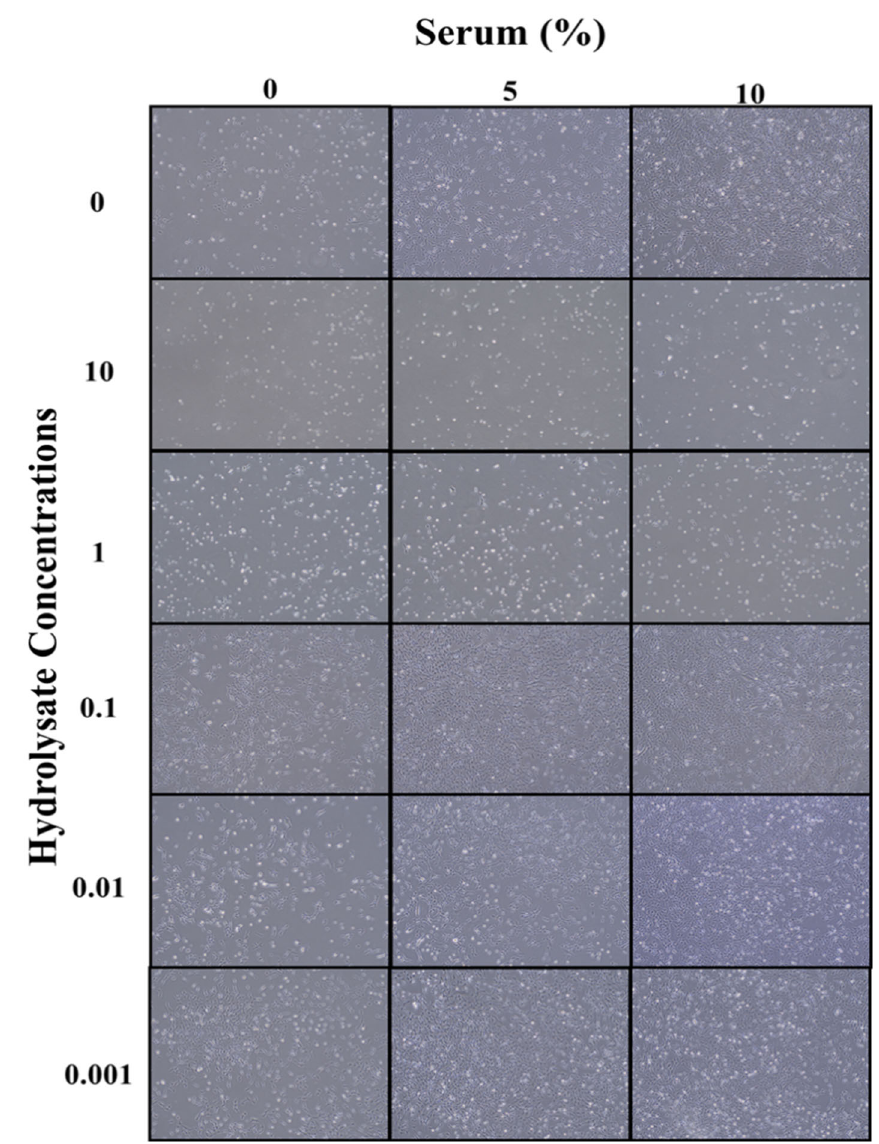
Figure 5. ZEM2S cells’ morphological changes in different media containing BSF hydrolysates (0–10 mg/mL) in combination with 0, 5, and 10% serum. The morphology was provided using phase‐contrast microscope (200 μ m).